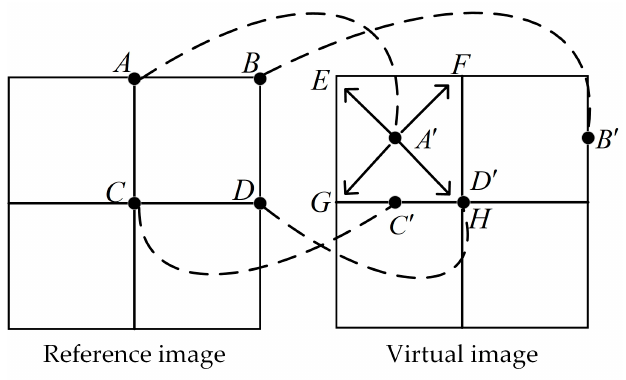
Figure 9. Schematic diagram of the modified 3D warping.